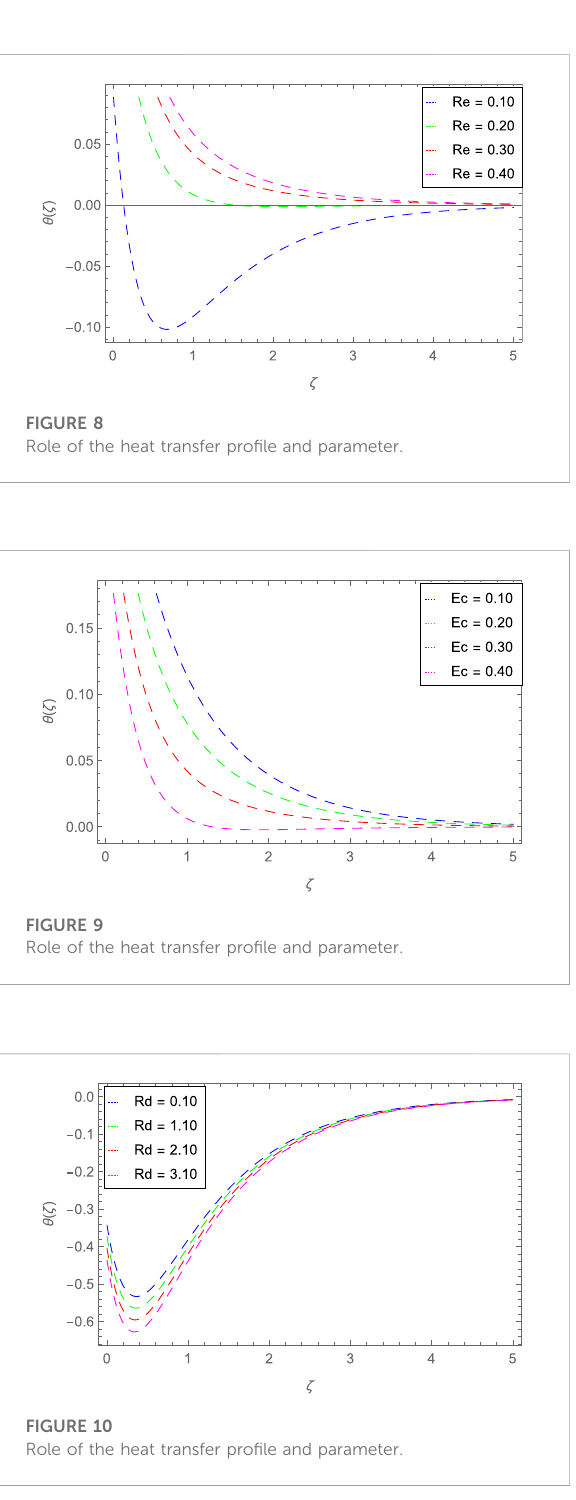
FIGURE 10 Role of the heat transfer pro fi le and parameter.